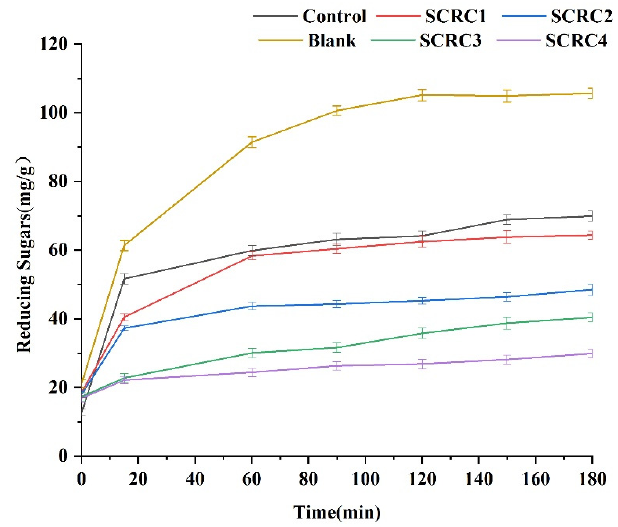
Figure 1. Amount of reducing sugars released from Sweet corn residue (SCR) cakes during in vitro digestion. Table 4. Effect of SCR on total sugar and in vitro digestion profile in samples.